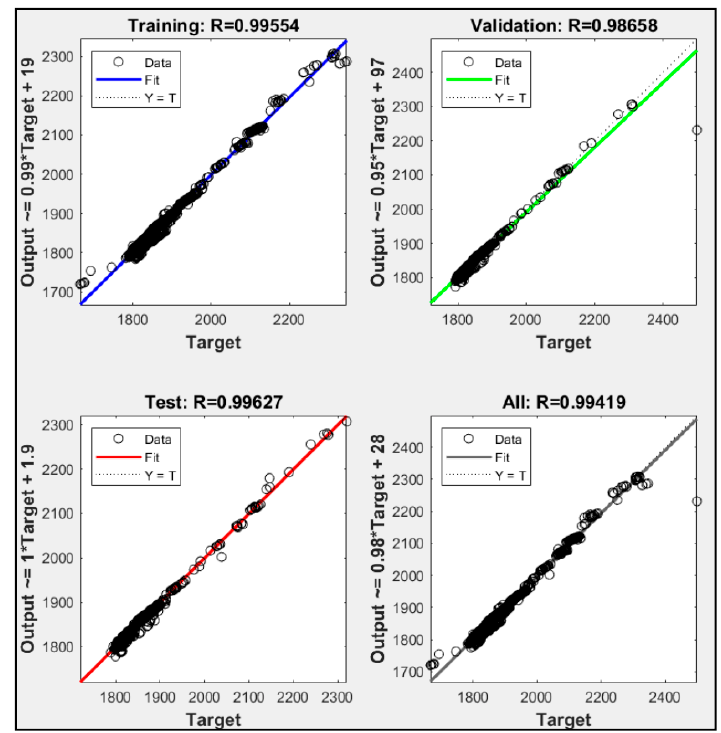
Figure 11. Regression result of P1 + P3.